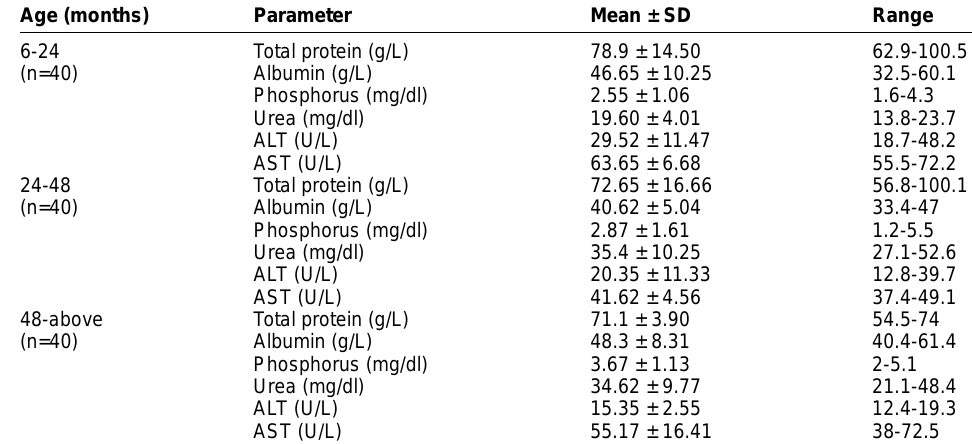
Table-2. Biochemical status of Black Bengal and Jamnapari goats Age (months)